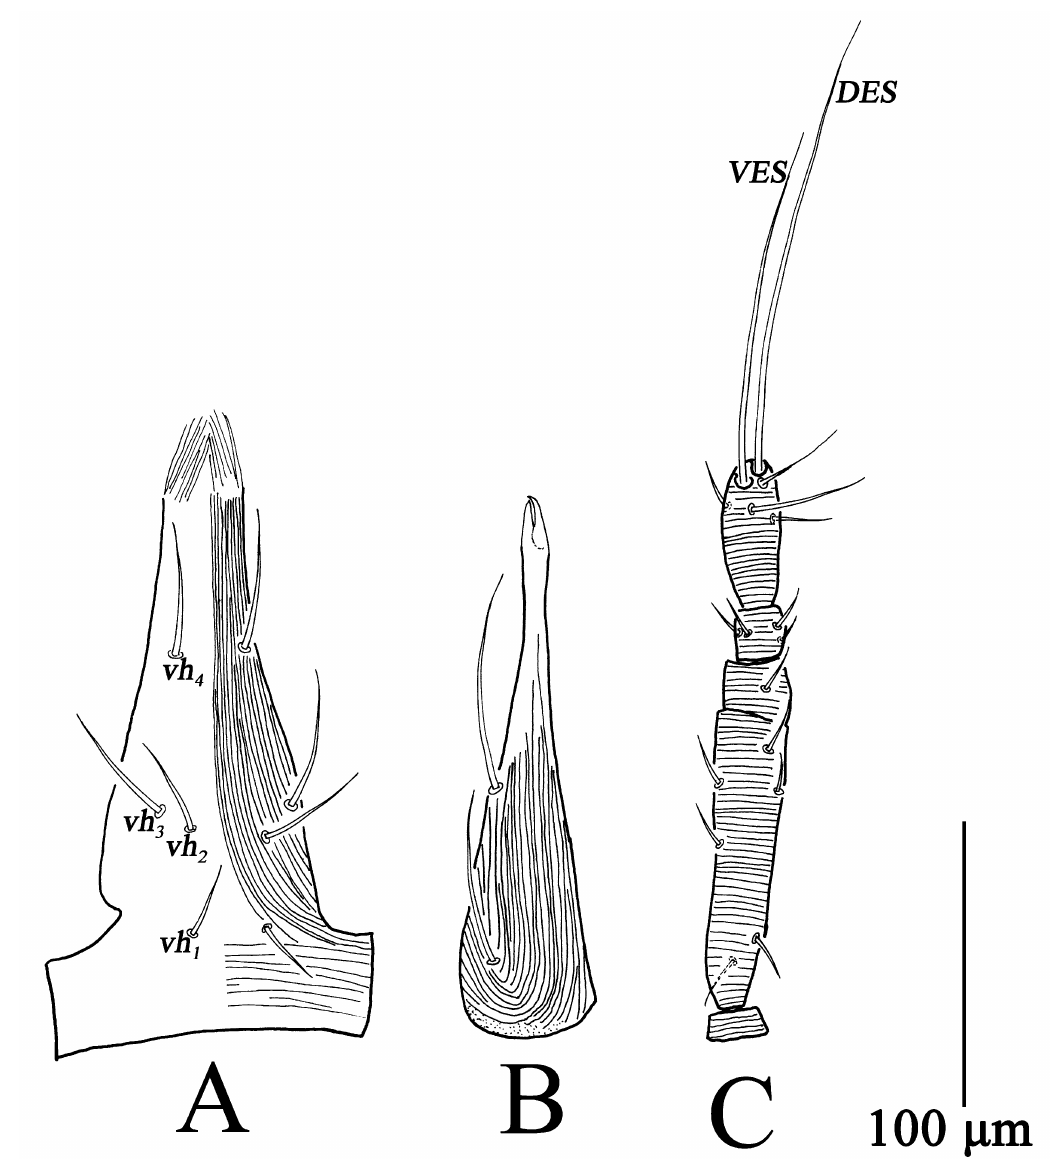
Figure 7. Bdella muscorum , deutonymph: ( A ) Subcapitulum; ( B ) Chelicera; ( C ) Palp. Dorsum (Figure 8A). Resembling tritonymph; prodorsal apodeme simple without re- ticulation; two pairs of lateral eyes, the anterior one 15 – 17, and the posterior one 14 – 15.